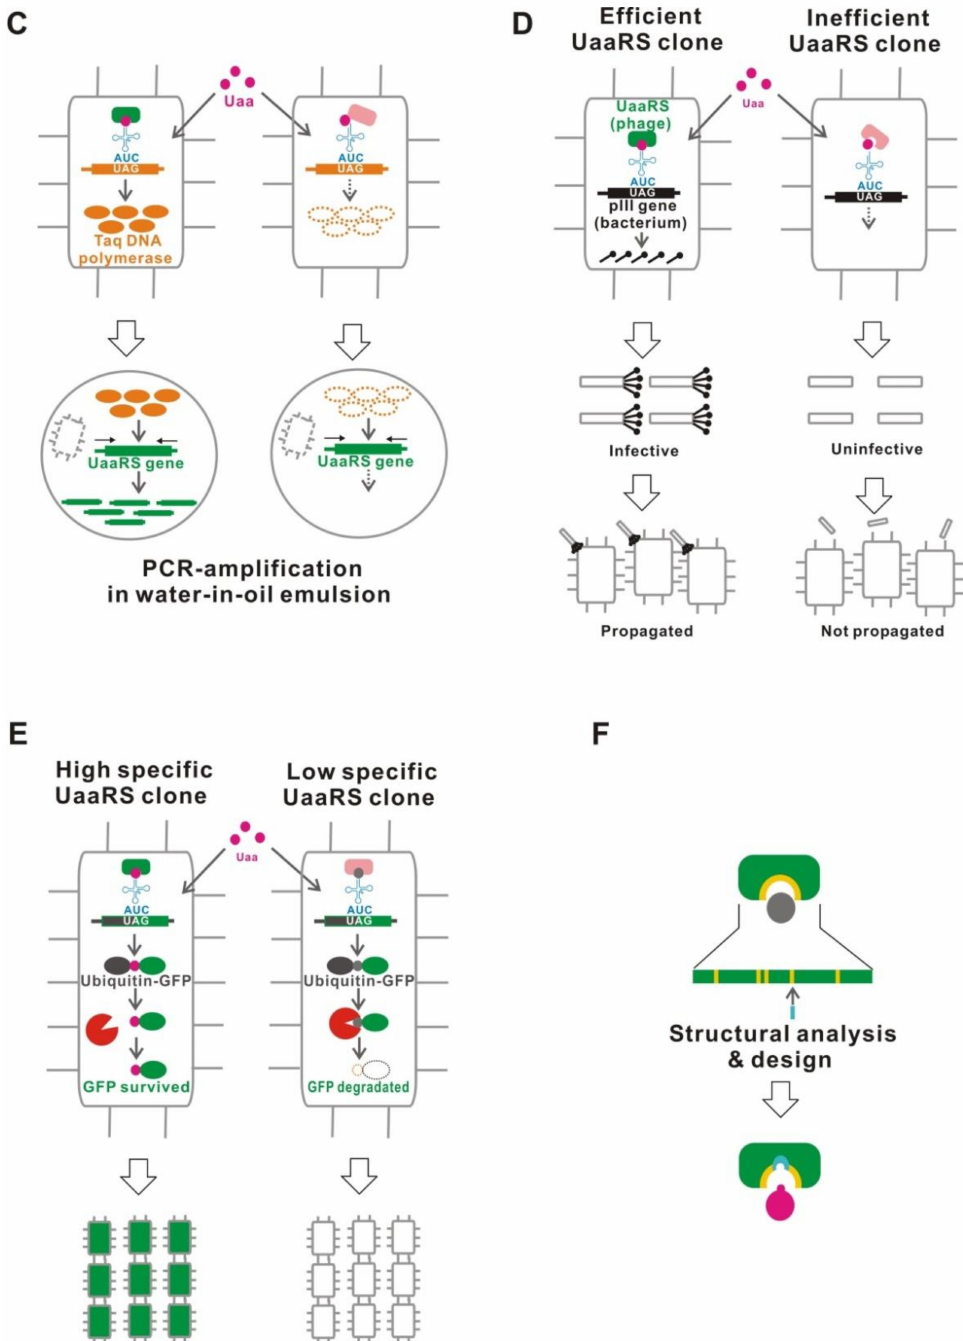
Figure 7. Improvement of UaaRS/tRNA CUA . ( A ) Traditional evolution method. A positive selection and a negative selection are performed to effectively isolate the Uaa incorporating and less Std. aa incorporating UaaRSs, respectively. (B ) Parallel positive selections combined with deep sequencing and statistical analysis. Positive selections are performed in the presence and absence of Uaa. Specifically-enriched sequences in the Uaa selection, which encode efficient and specific UaaRSs, are identified after deep sequencing. ( C ) Compartmentalized partnered replication. DNA sequences that encode highly active UaaRSs are selectively amplified in compartmentalized micro-drops. ( D ) Phage-assisted continuous evolution. Phage carrying a highly active UaaRS are selectively propagated. ( E ) Post-translational proofreading. The proteins containing certain desired N -terminal Uaas have longer half-lives. Genes encoding highly specific UaaRSs are identified in bacteria expressing high amounts of GFP. The bacteria can then be isolated using a cell sorter. (F) Molecular design based on structural